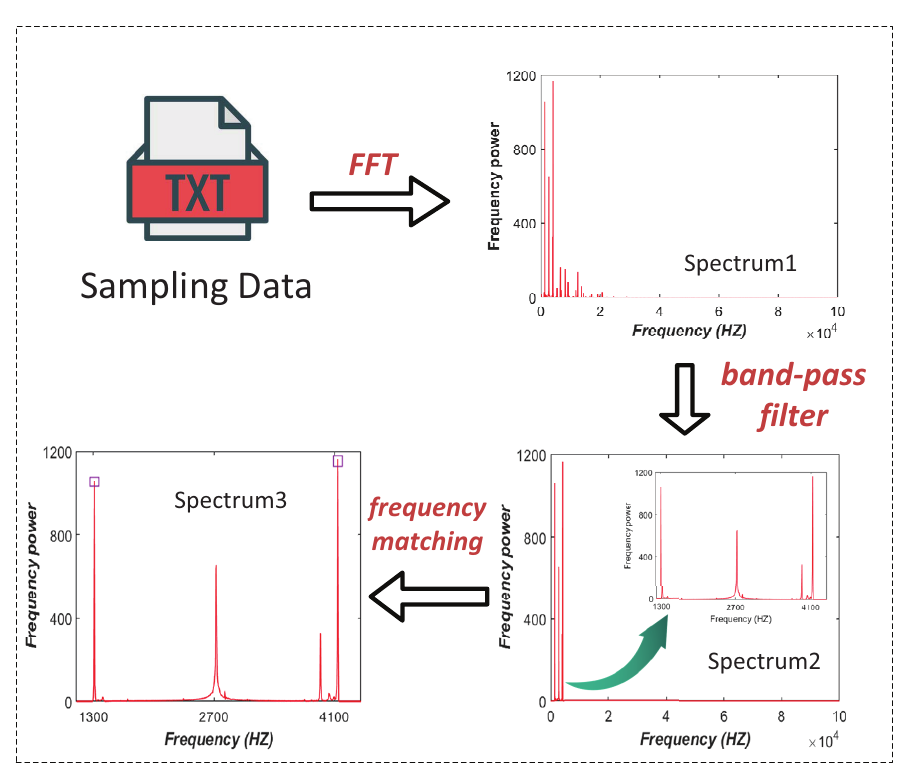
Figure 6. Frequency separation of two LEDs with the PWM frequencies of 2300 Hz and 2500